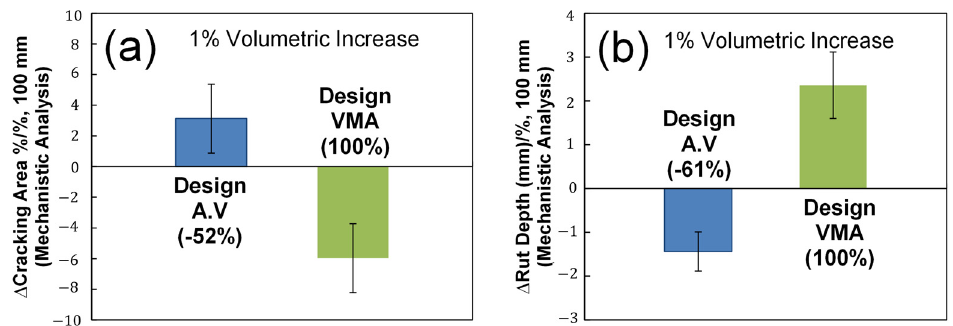
Figure 12. Sensitivity analysis results of individual volumetric AQCs on predicted mechanistic fa- tigue and ru tt ing performance: ( a ) fatigue damage area (%) and ( b ) asphalt rut depth (mm).